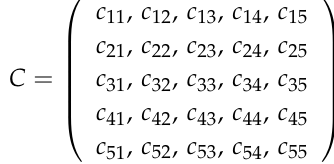
Figure 13. Block diagram of the proposed method. GRF signals and AHRS signals are used to obtain the elements of the time series. The GRFs signals in the swing phase are ignored since it does not change. The trained SVM is obtained offline in MATLAB and the online testing is conducted in Visual Studio.